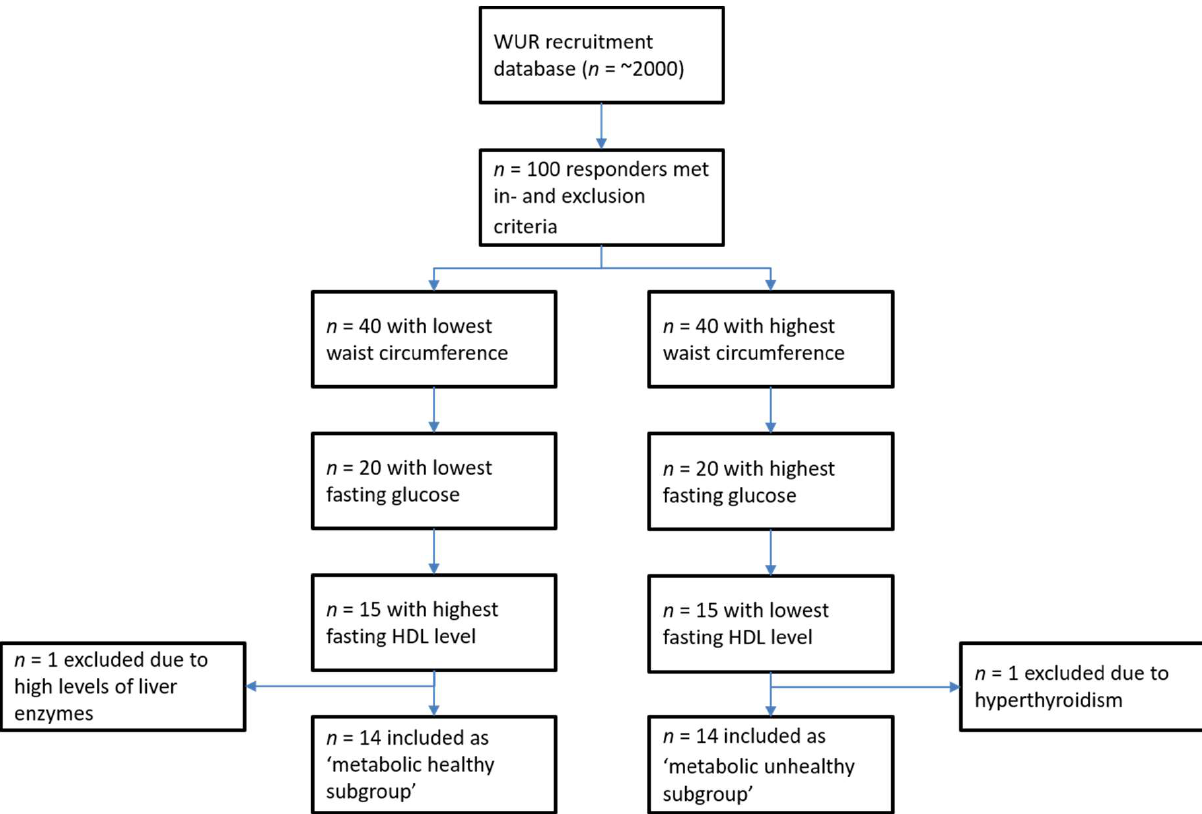
Figure 1. Overview of the selection procedure.